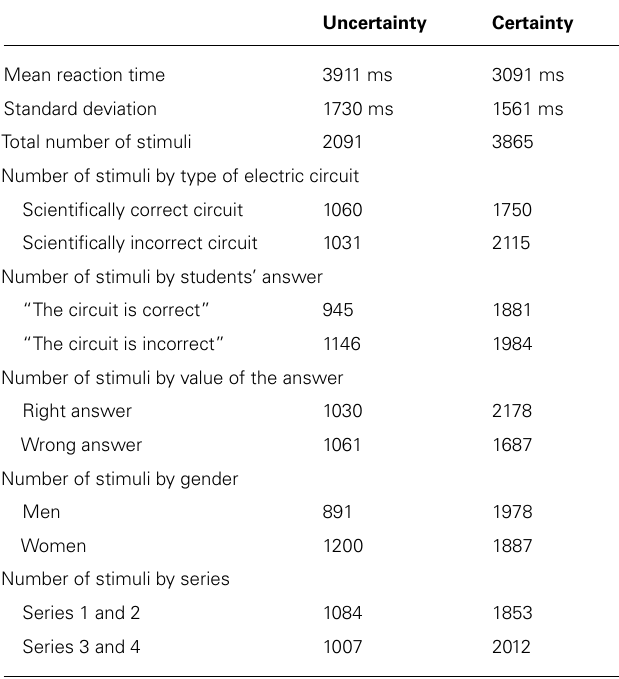
Table 1 | Overview of the behavioral task